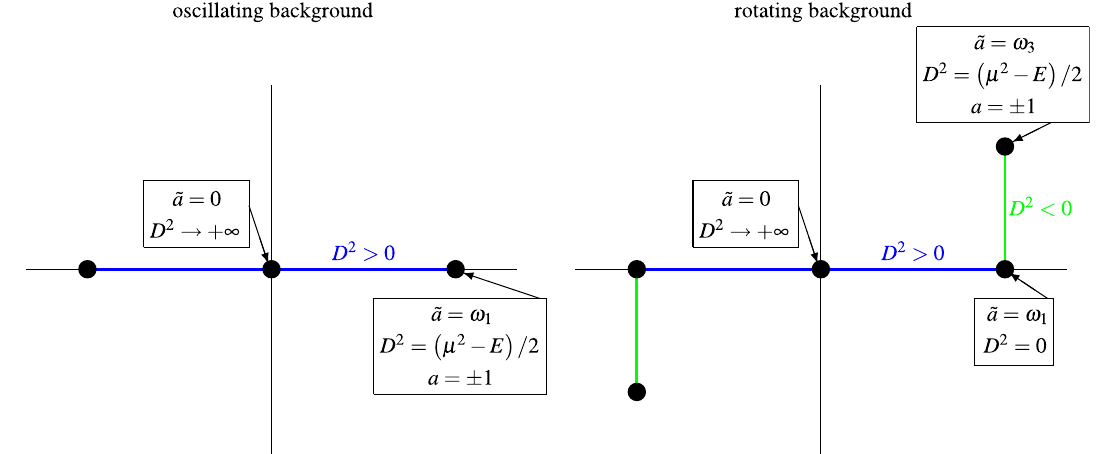
Fig. 2 The allowed values of ˜ a in the complex plane. Each point in the ˜ a complex plane corresponds to two discrete values of the Bäcklund parameter a , differing only in their